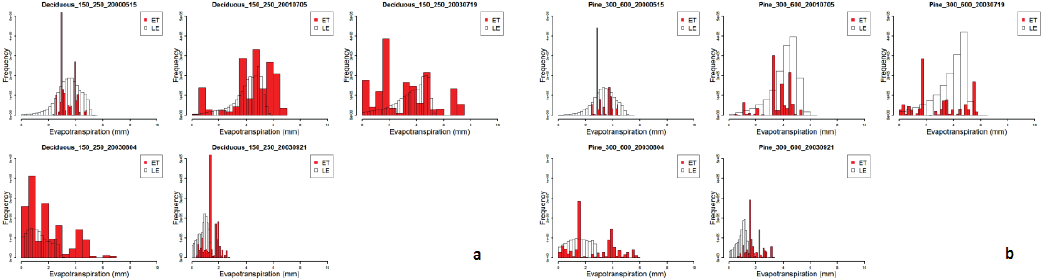
Fig. 5 Five days’ frequency distribution of (a) ET 150_250 and LE in deciduous forest and (b) ET 300_600 and LE in pine